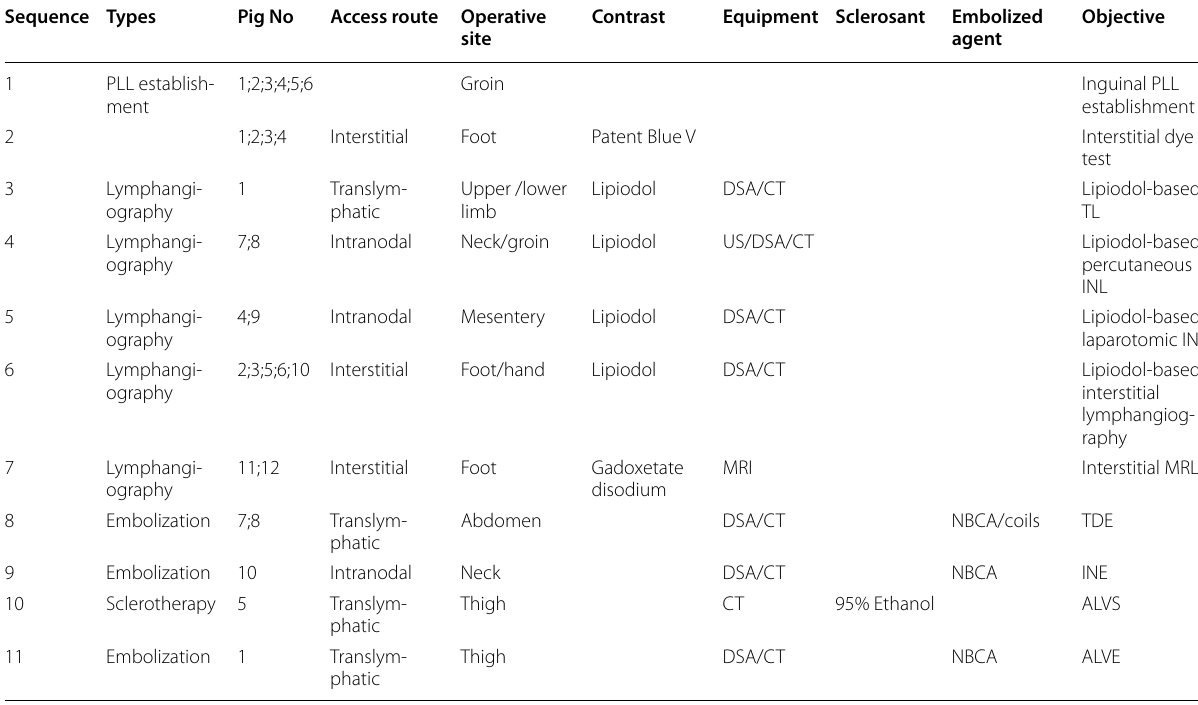
Table 1 A summary of different procedures in pig